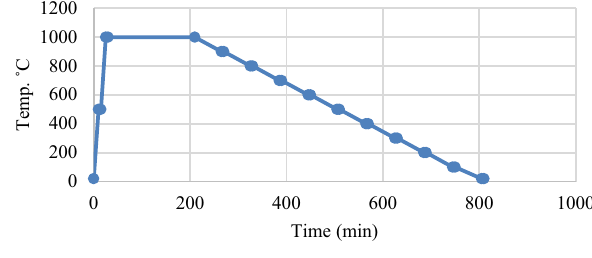
Fig. 3 Heating cycle